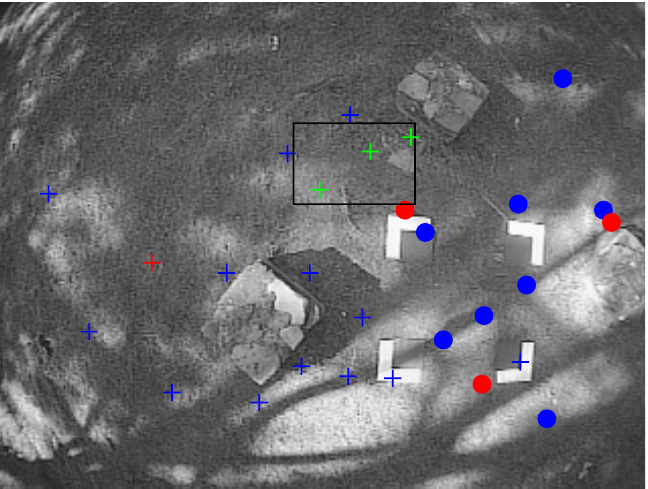
Figure 4. Candidate points are detected randomly in image regions without map features or candidate points. In this frame, the black rectangle indicates the current search region. Three new candidate points have been detected (green cross-marks). Candidate points being tracked are indicated by blue cross-marks. Visual features already mapped are indicated by circles. Red marks indicate unsuccessful